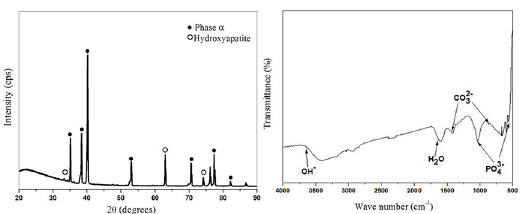
Figure 4. Characterization of cp-Ti at condition C0 (cp-Ti+HA). (a) X-ray diffractogram. (b) Infrared